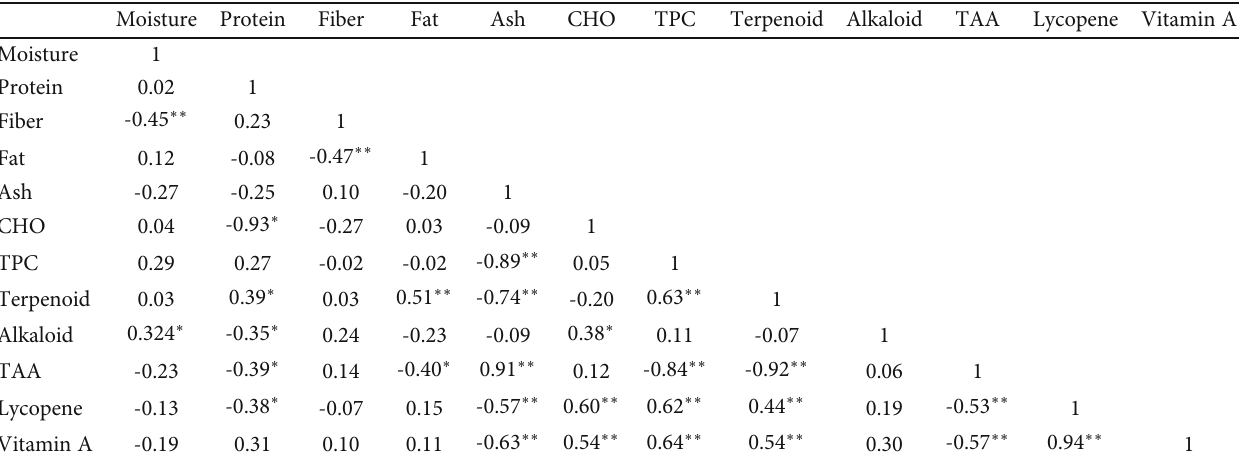
Table 5: Correlation between proximate composition and antioxidant properties of the formulated